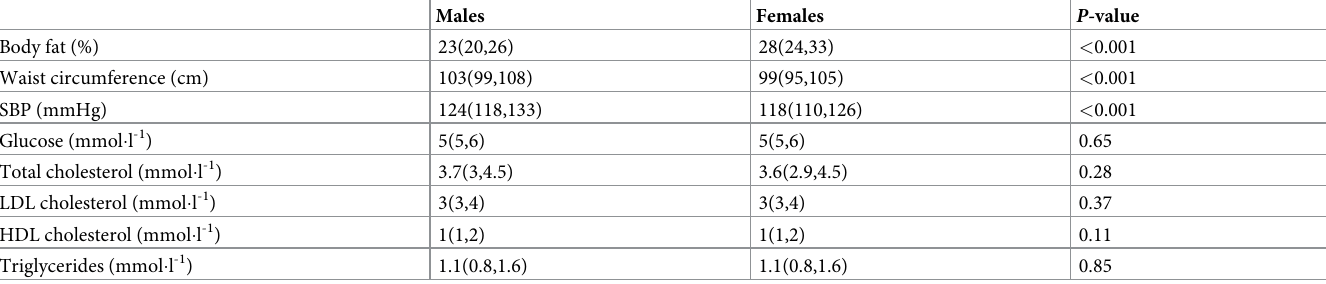
Table 1. Demographical data separated by gender (mean; 95% confidence